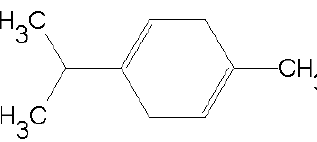
Figure 1. Chemical structure of 1-Isopropyl-4-methyl-1,4-cyclohexadiene (C